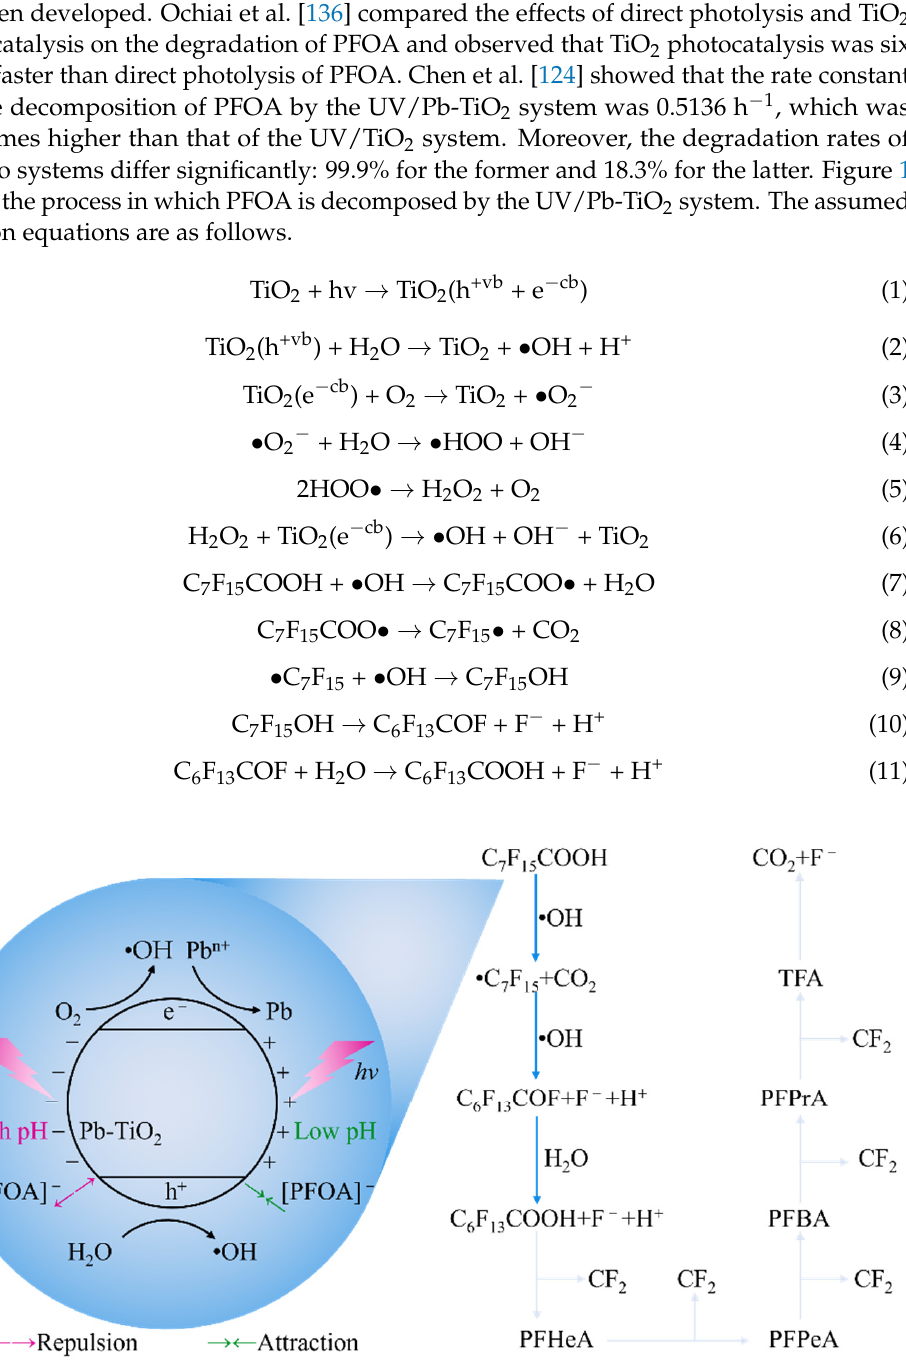
Figure 1. Photocatalytic pathways of PFOA decomposition. Reprinted with permission from reference Mengjia Chen, Shanglien Lo, Yuchi Lee, Jeff Kuo, Chunghsin Wu, 2016, [124].